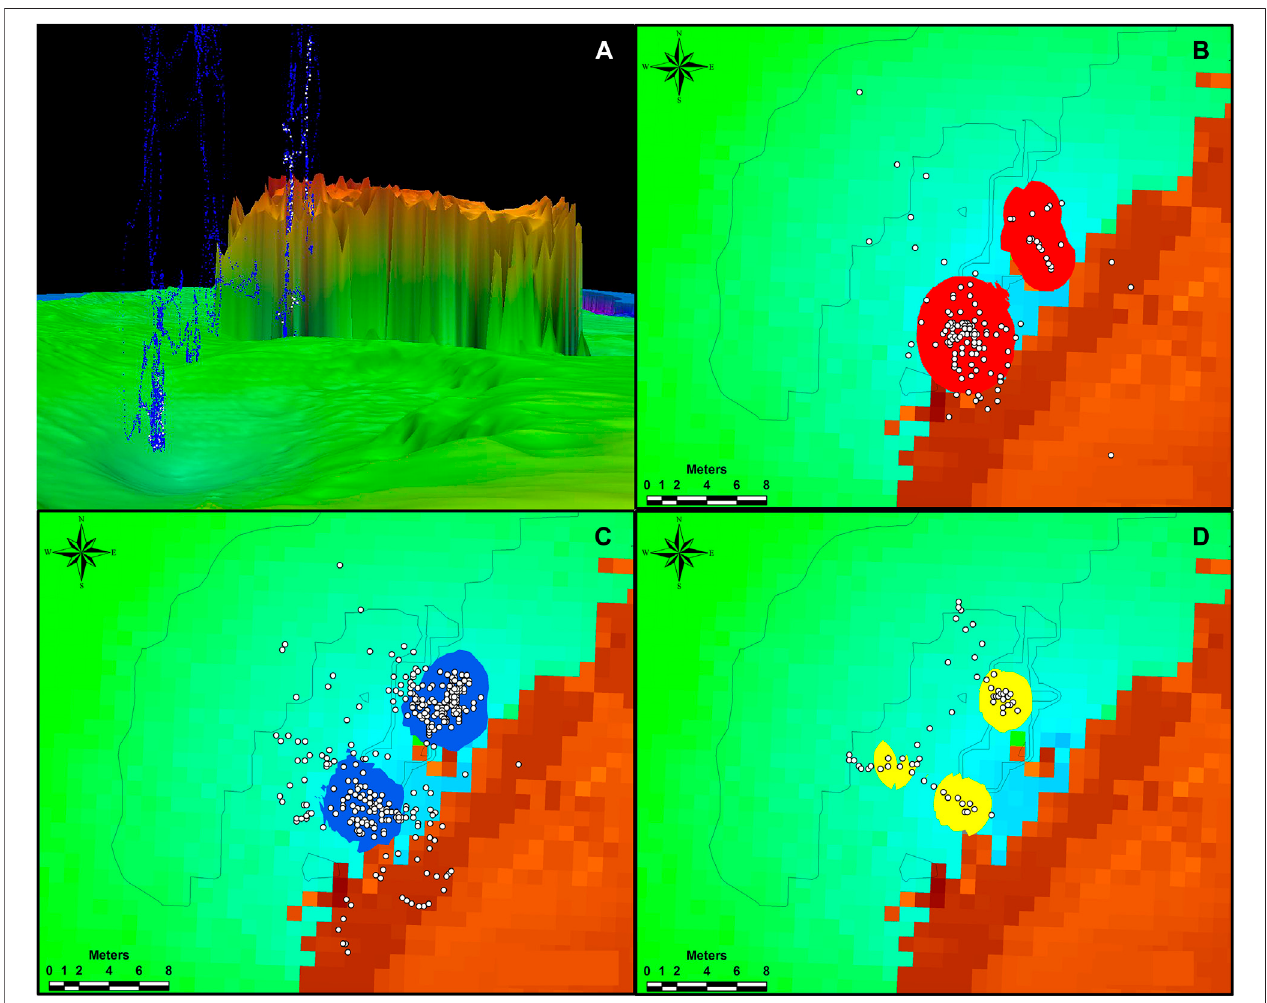
FIGURE 8 | Locations of image samples from the plume: (A upper left) vertical plot, blue points show the ROV locations during sampling and white points show where video image sampleswere taken; outline ofthe well jacket isapproximately 10 m above the seabed (green); (B upper right) samplesfrom the plume in the crater withtheoutlineofthe kernel polygon forthis interval; (Clowerleft) samples fromthe plume inthebenthiclayer withthe outlineofthekernel polygon forthisinterval; and (Dlowerright) samplesfromtheplumeinmidwaterwiththeoutlineofthekernelpolygon.Brown colorrepresentsthelocationofthecollapsed welljacket, original Fig. 4.11 (Mason et al., 2019).